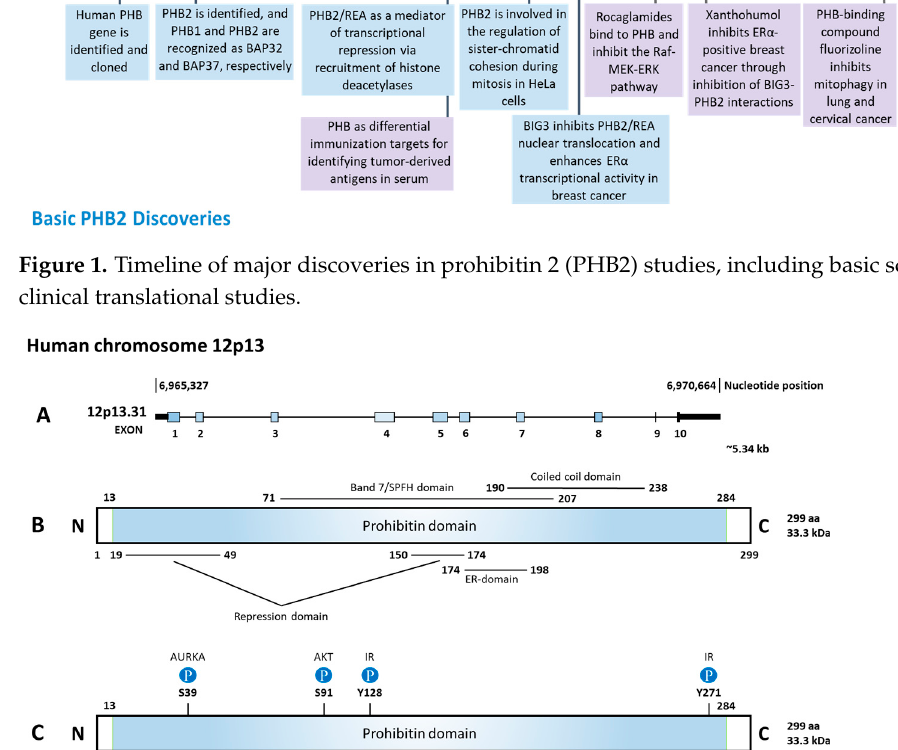
Figure 1. Timeline of major discoveries in prohibitin 2 (PHB2) studies, including basic science and clinical translational studies.